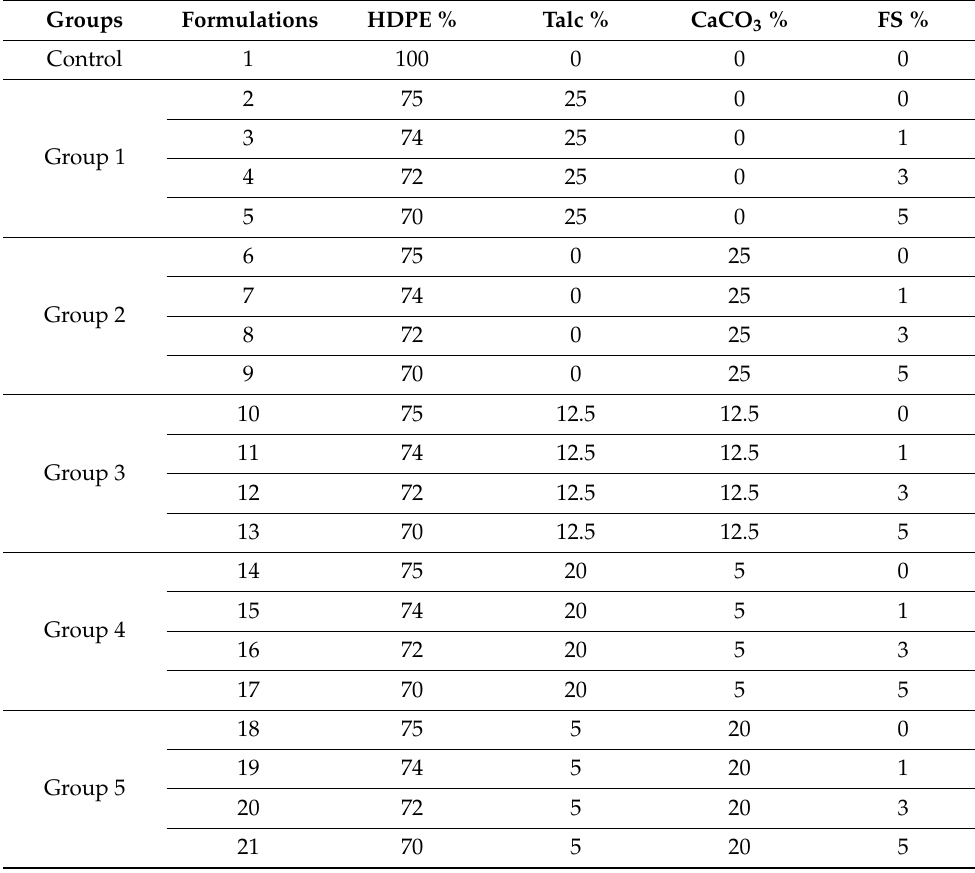
Table 1. Compositions of the different HDPE/filler composites formulations. Groups